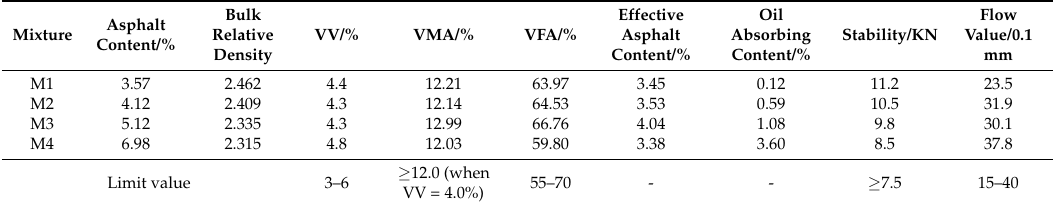
Table 4. Marshall indices of